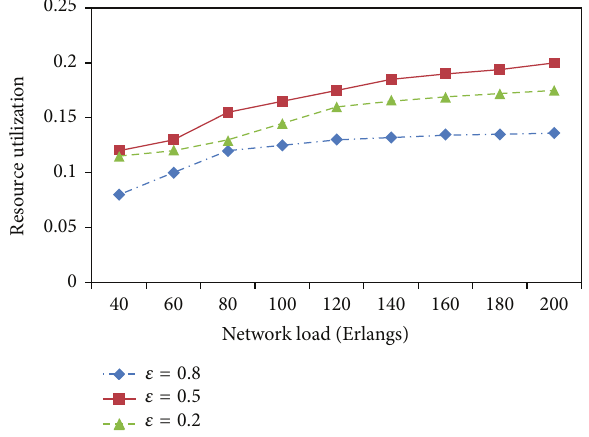
Figure 3: Resource utilization for varied 𝜀 .